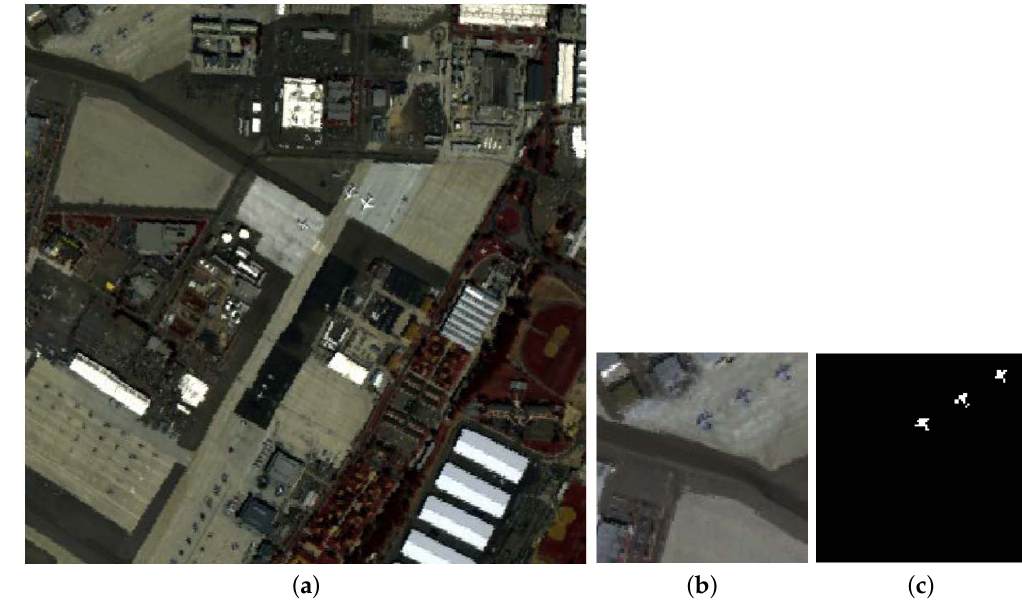
Figure 7. The second Hyperspectral Image (HSI2). ( a ) The false color image of the entire image; ( b ) The false color image of the chosen area for detection; ( c ) The ground-truth map of the chosen area